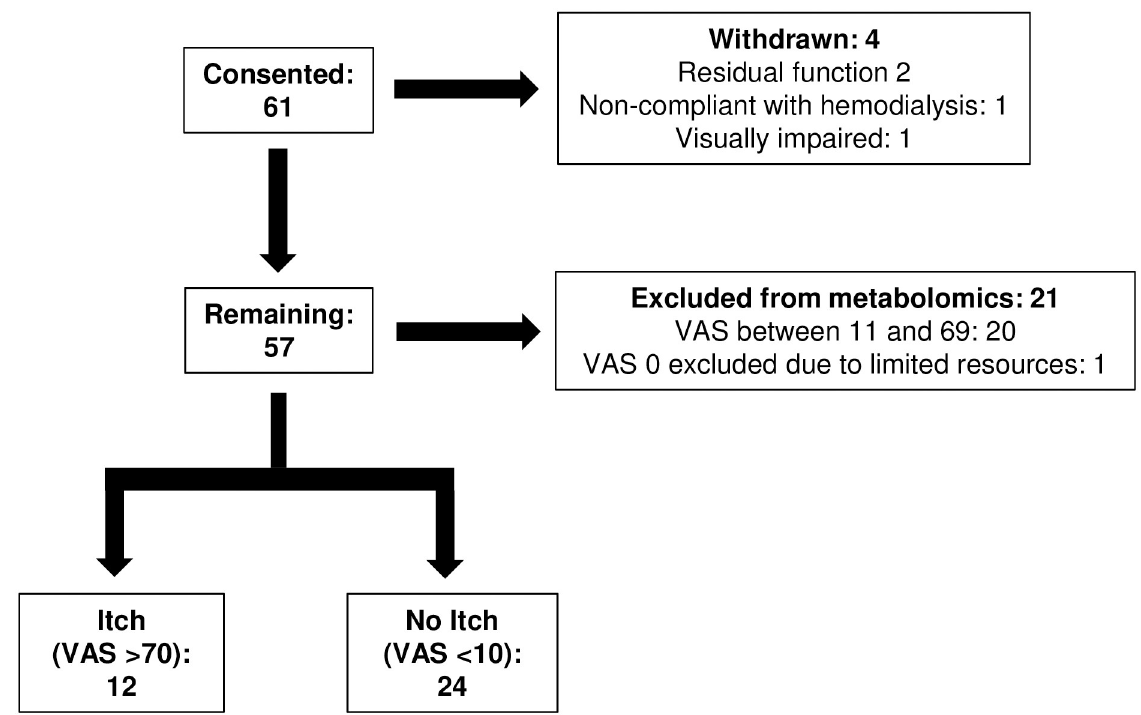
Fig 1. Patient enrollment flow chart. Of 61 patients, 12 patients with severe pruritus (Itch, VAS > 70 mm) and 24 patients with mild/no pruritus (No Itch, VAS < 10 mm) were included for metabolomic analysis. VAS, visual analogue scale.